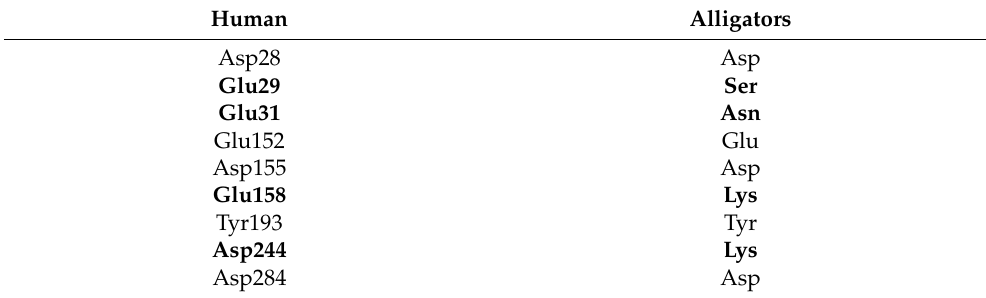
Table 2. Comparison of the acidic pocket amino acids between humans and